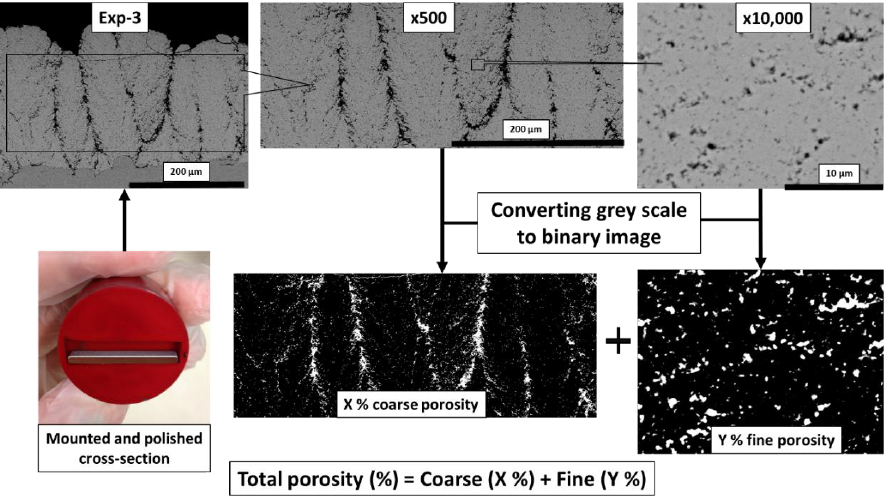
Figure 2. A schematic of the two-magnification image analysis procedure adopted in this